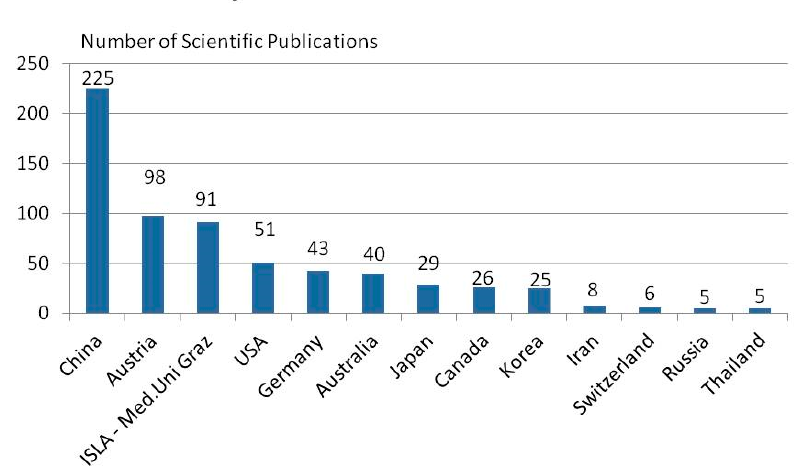
Figure 1. Ranking of countries according to the number of published scientific articles (the majority in the English language) on laser acupuncture.